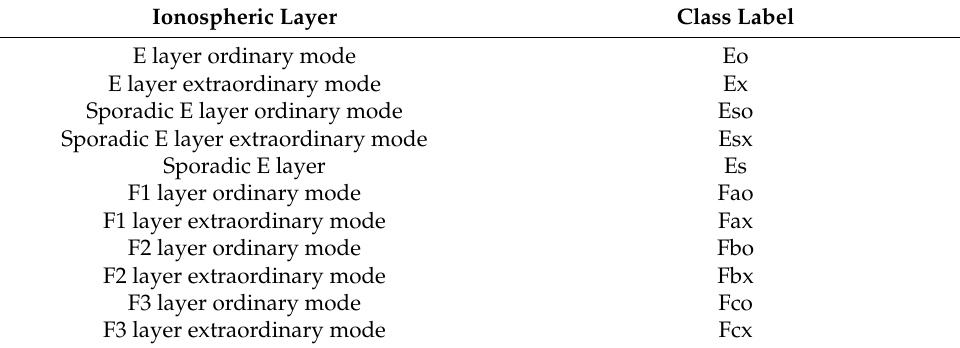
Table 1. Ionospheric layers with their corresponding label names.